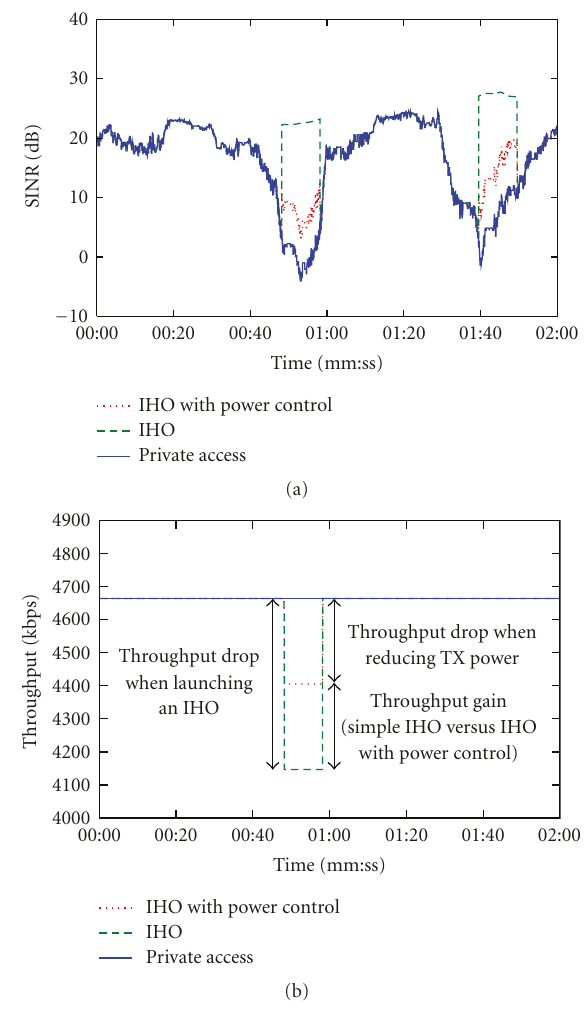
Figure 5: SINR level of a mobile